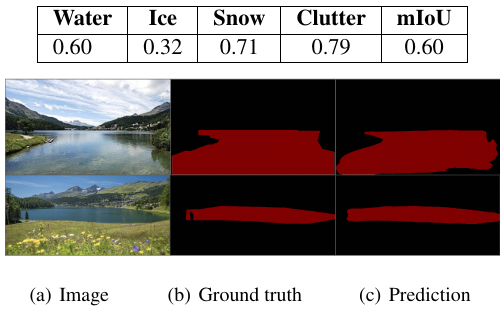
Figure 13: Lake detection on crowd-sourced data.